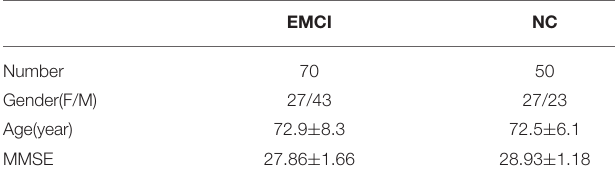
TABLE 1 | Corresponding statistical information of subjects.